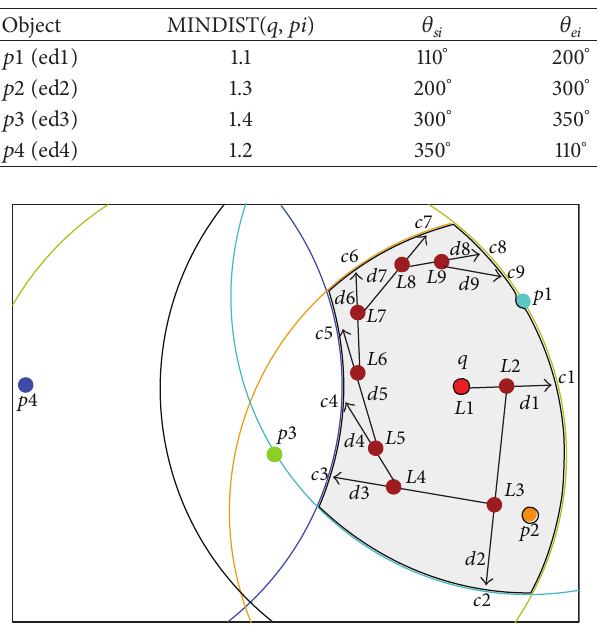
Figure 8: Arbitrary moving query inside safe